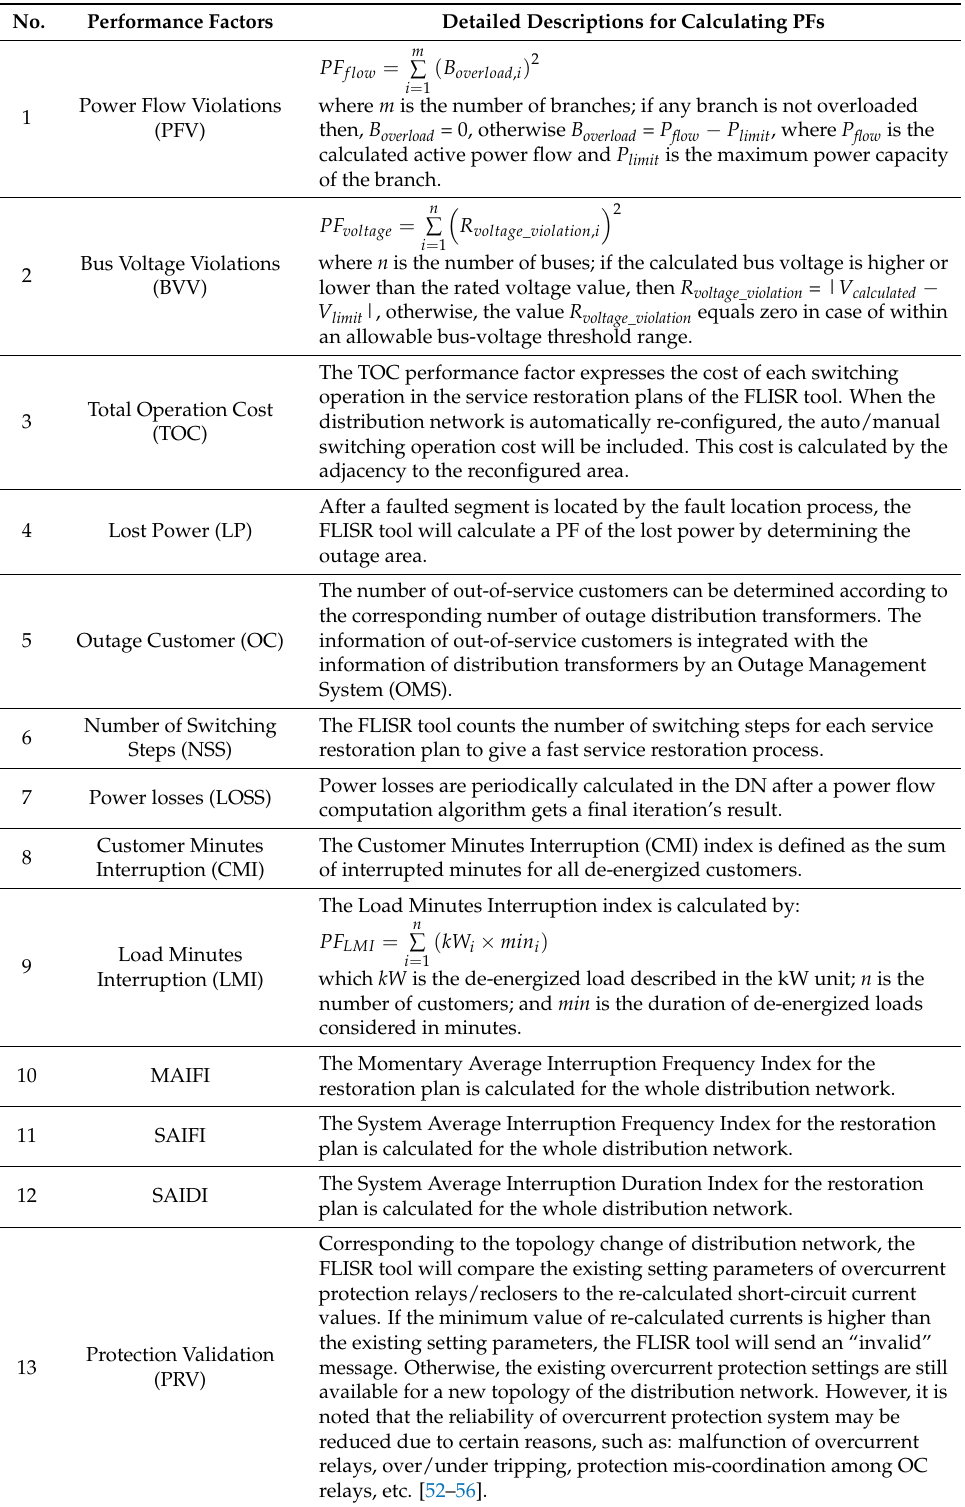
Table 5. Performance factors used for service